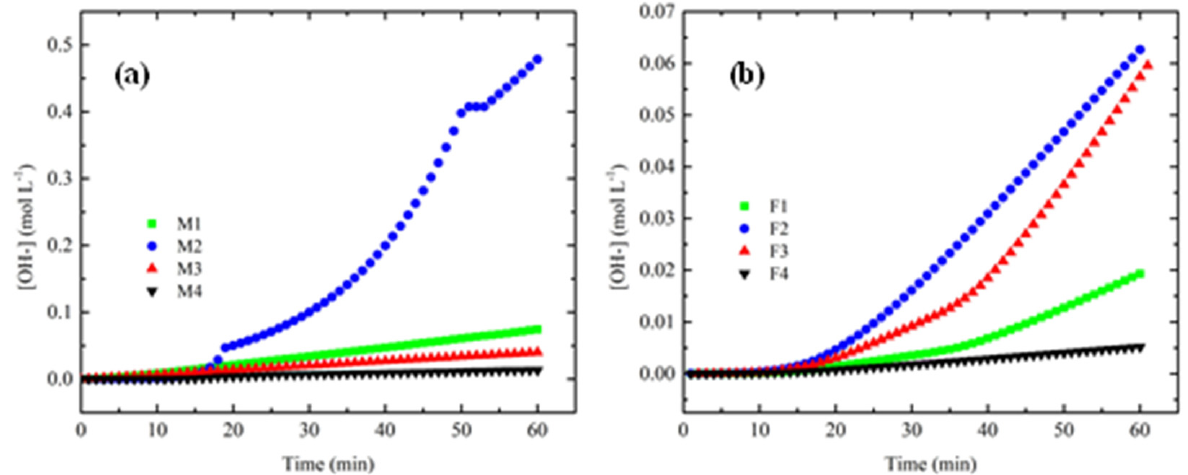
Figure 13. HIER for first 60 min of process for: ( a ) PEI and ( b ) Fumion ® .